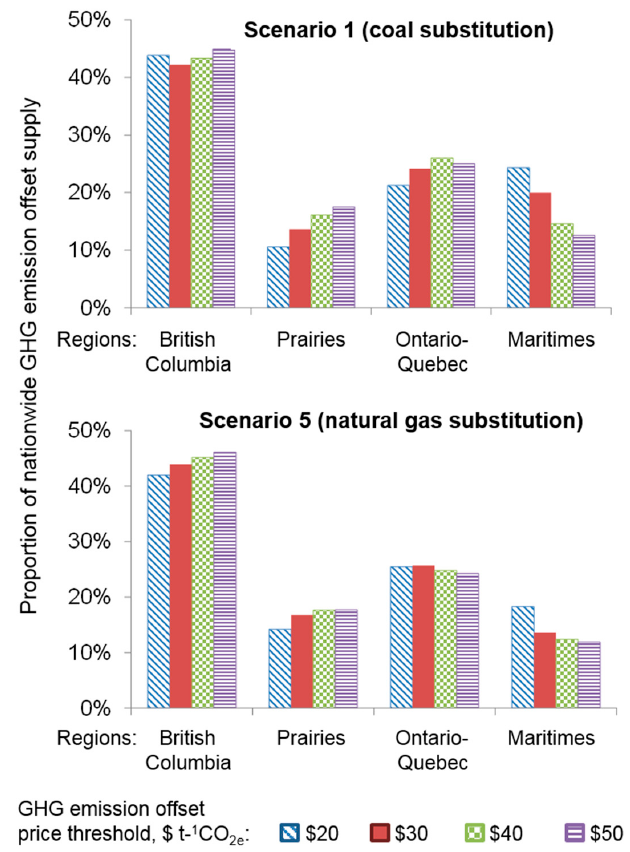
Figure 3. Relative proportions of nationwide greenhouse gas (GHG) offset supply by geographic regions (%) at different GHG emission offset price thresholds; Prairies: Alberta, Saskatchewan, Manitoba, Maritimes: New Brunswick, Nova Scotia, Newfoundland. Scenario 1 for coal and Scenario 5 for natural gas substitution are shown. (Both scenarios use baseline cost assumptions, ecological sustainability constraints, and the 2010 nationwide harvest levels).